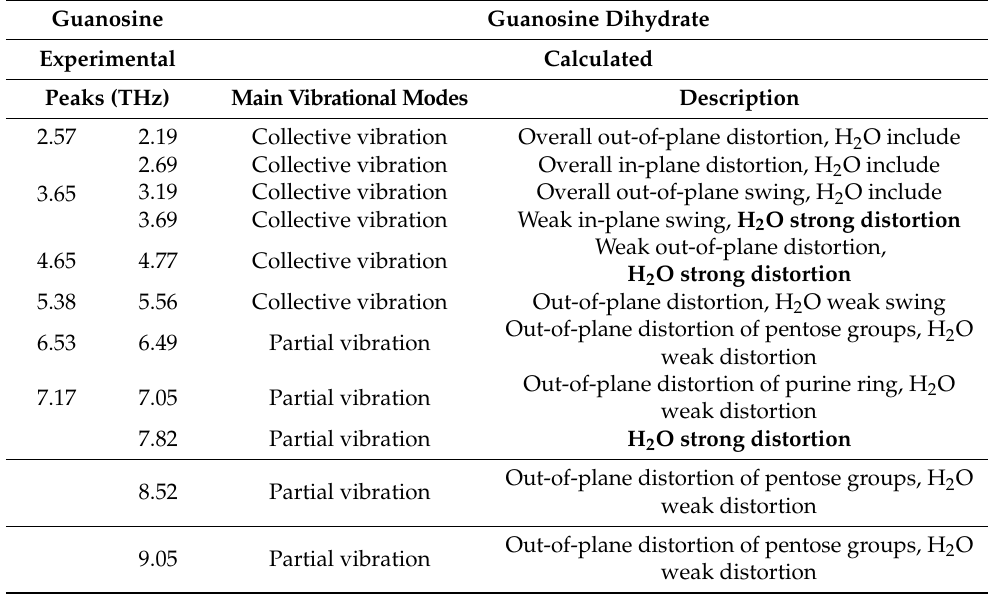
Table 3 displayed the positions of all characteristic peaks and corresponding